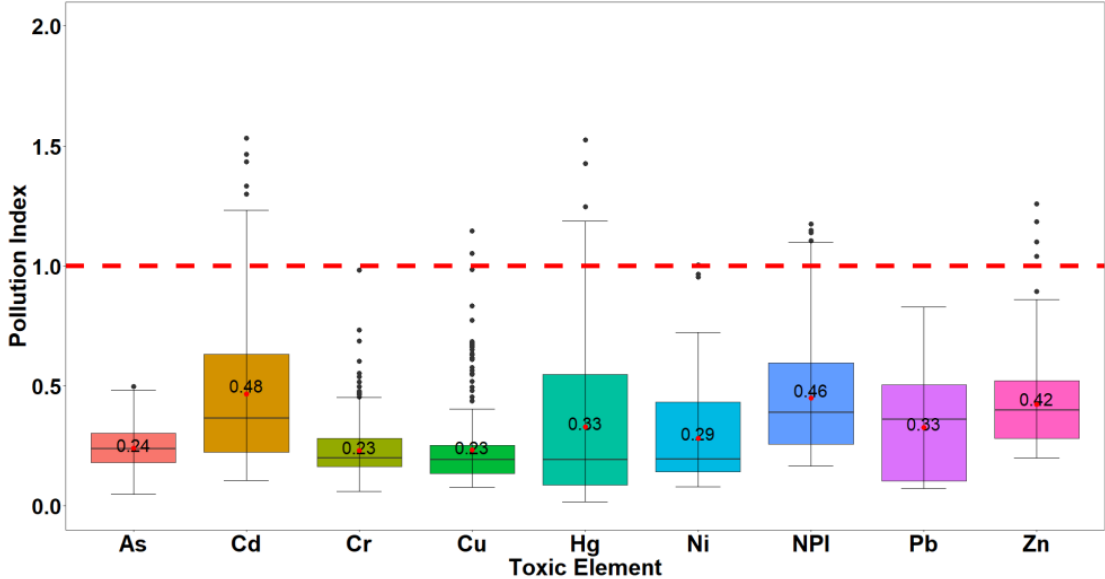
Figure 5. Boxplot of values of single PI and NPI (the red dashed line means the threshold for occurrence of pollution). The proportions of PI values of TEs in soil samples at different pollution levels are Table 4. Pollution status assessed by pollution index ( n = 300). provided in Table 4. Similar to the I geo and ER indices, the PI of Cr, Pb, and As in all soil samples were at a safe level, while only a small part of the soil samples had PI